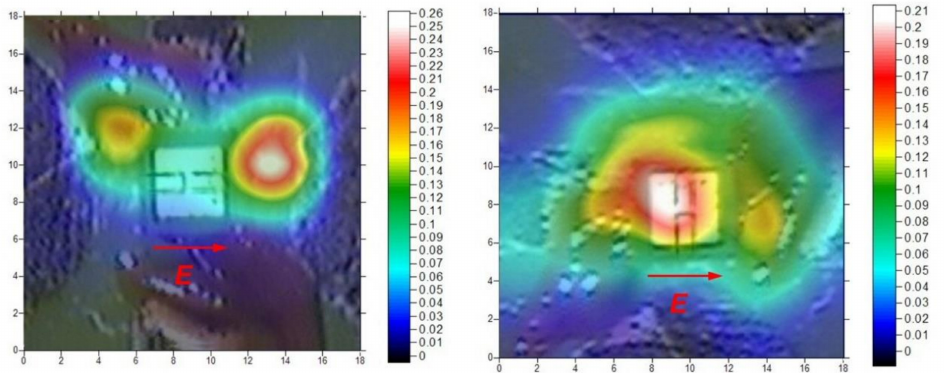
Figure 3. Detectivity map of a High Electron Mobility Transistor (HEMT) detector at 150 GHz for 2 di ff erent polarizations of the electric field of the Free Electron Laser (FEL) radiation. A signal from the HEMT device is superimposed over the THZ image of the